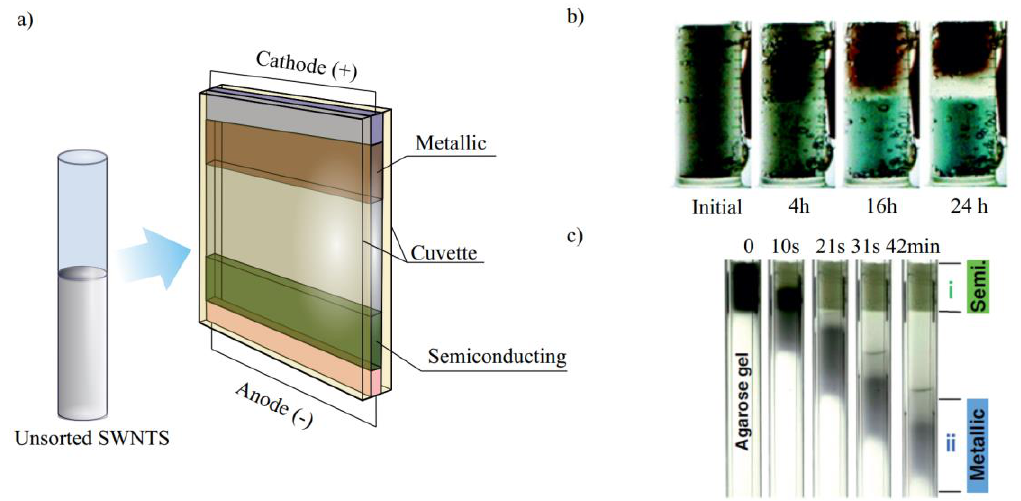
Figure 13. ( a ) Schematic of a vertical electrophoretic cell for a SWCNT separation. Metallic SWCNT (brown) having a high dielectric constant moves towards an electrode for the high applied electric field. Lower dielectric constant semiconducting SWCNT (green) is left in the solution. ( b ) Optical pictures taken before, 4, 16, and 24 h after the application of voltage on the SWCNT solution in a vertical cell (30 V). Nanotubes have a diameter of 1.0 nm [90]. Copyright 2011, American Chemical Society. ( c ) Separation of SWCNTs dispersed in gel by AGE. Optical images showing the progress of separation [86]. Copyright 2008, American Chemical Society.